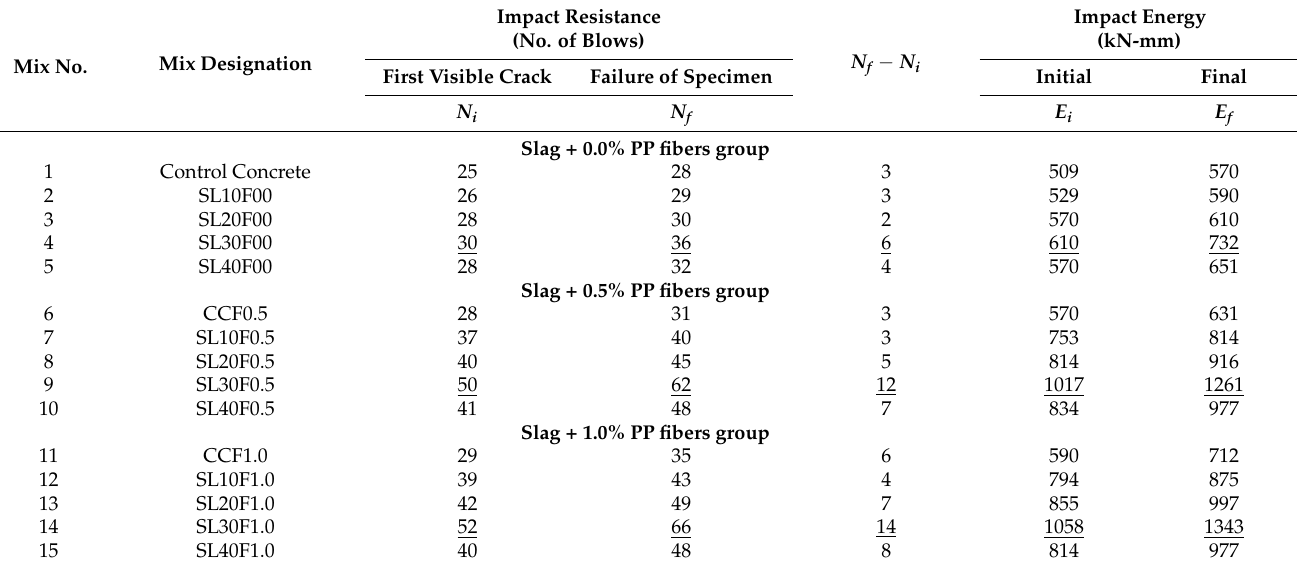
Table 8. Drop weight impact test